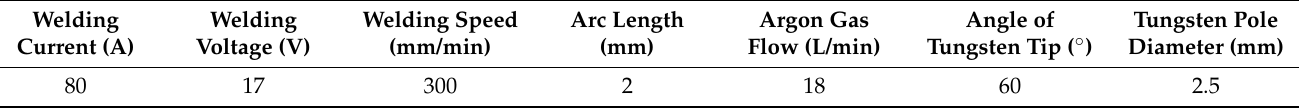
Table 2. Welding process